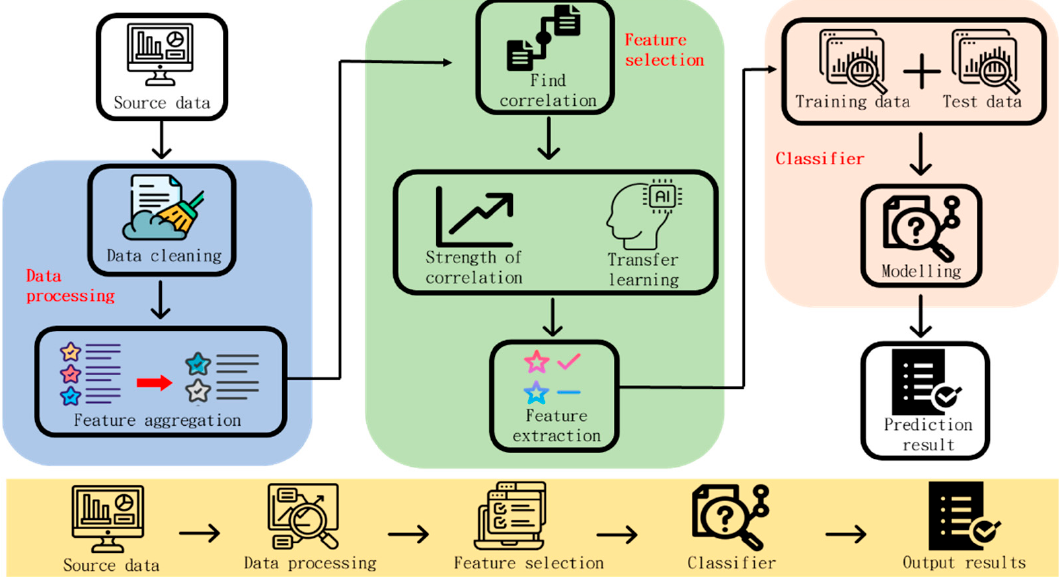
Figure 1. Overview of the proposed system.